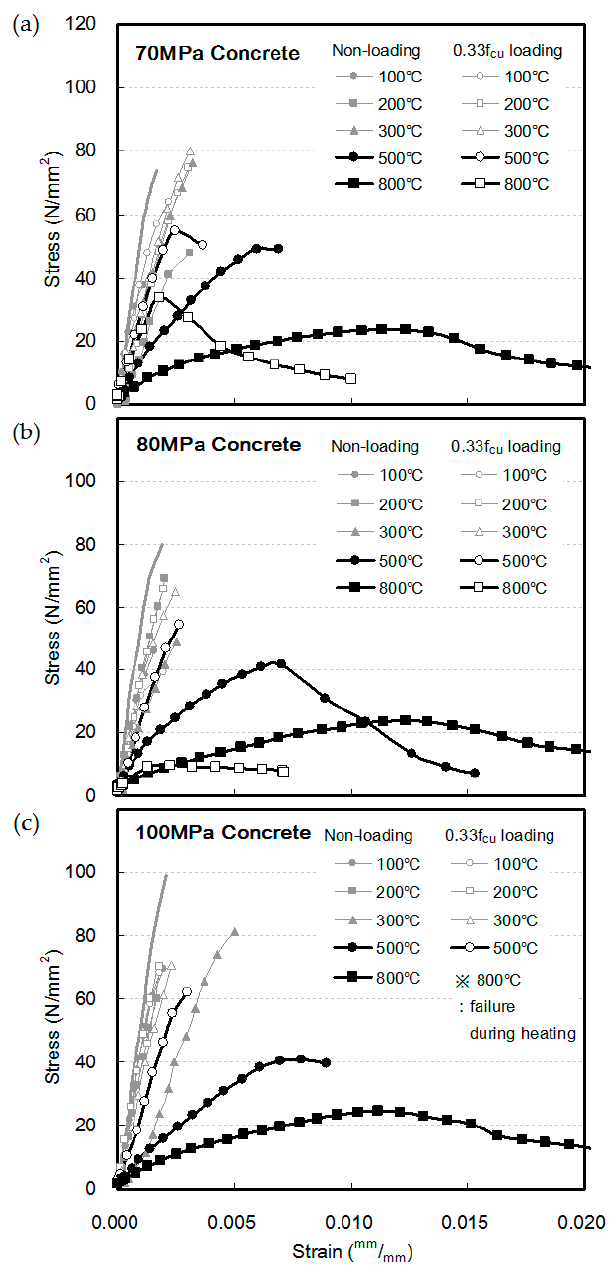
Figure 5. Stress–strain relation of high strength concrete at elevated temperatures: ( a ) 70 MPa; ( b ) 80 MPa; ( c ) 100 MPa.